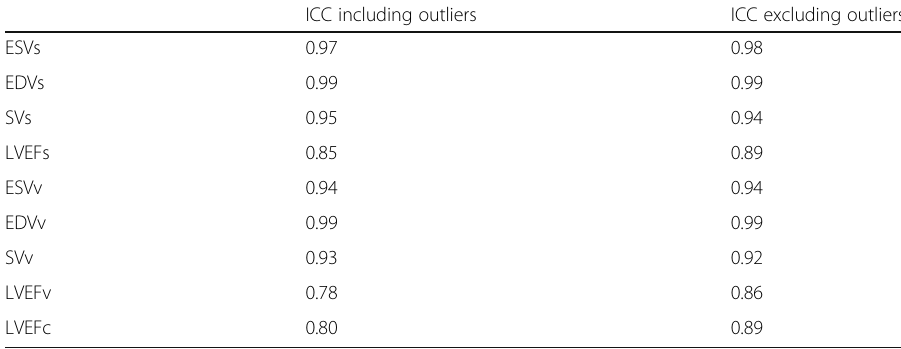
Table 6 Intraclass correlation coefficient (ICC) for inter-operator repeatability including and excluding outliers ( p < 0.001 for